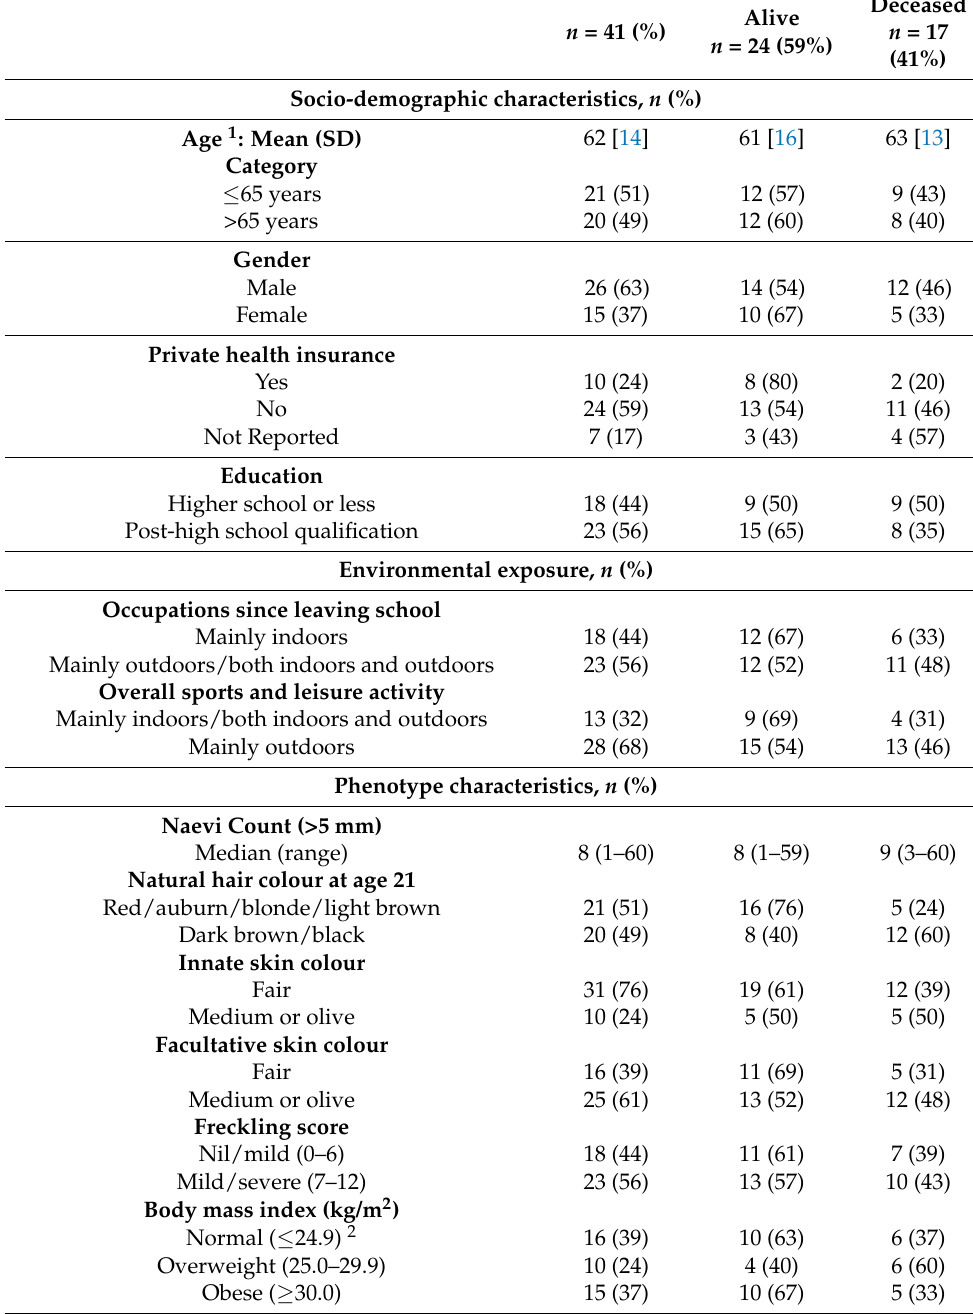
Table 1. Baseline sociodemographic and clinical characteristics (frequency, column percentages) of participants with advanced melanoma by survival status (frequency, row